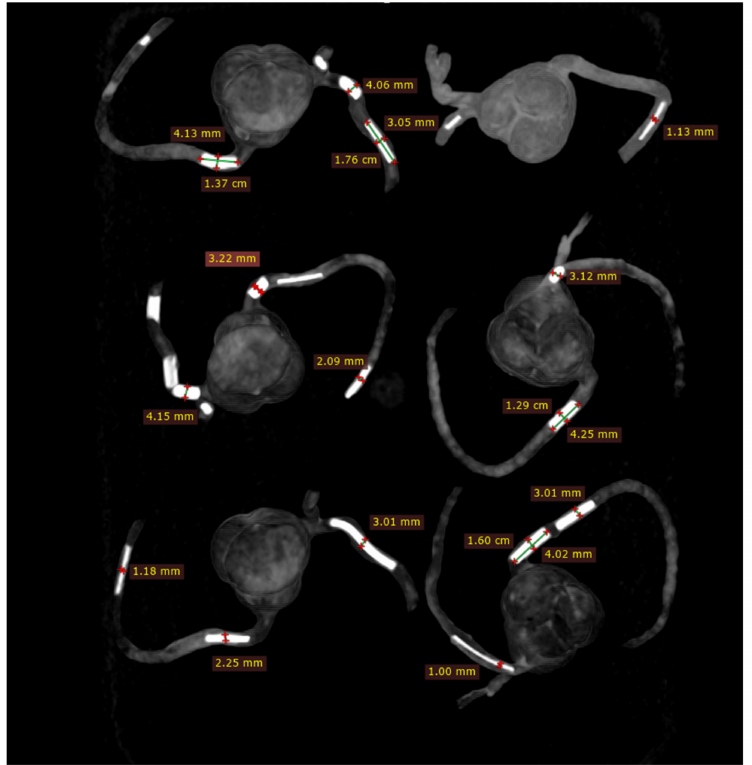
Figure 5. Measurements of plaque dimensions on 2D maximum-intensity projection images with 1.0 mm slice